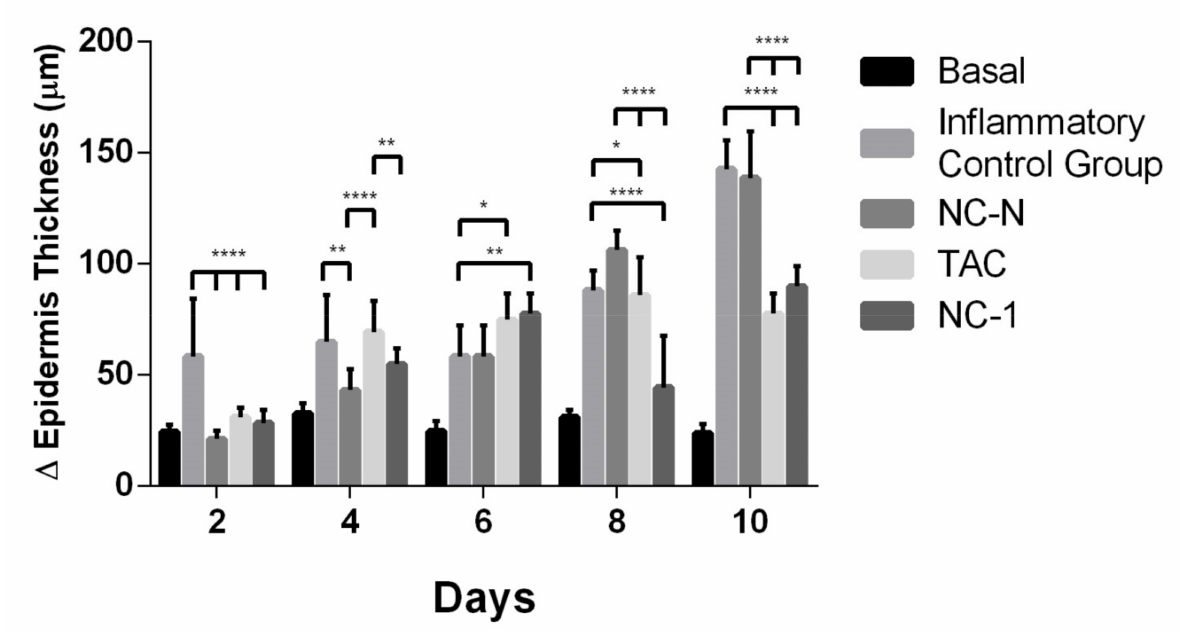
Figure 8. Effect of TAC, non-loaded, and TAC-loaded nanocapsules (NC-N and NC-1) on the variation of epidermis thickness of male Balb/c mice ears induced by TPA. Statistical analysis performed on each group on days 2, 4, 6, 8, and 10 of treatment. ANOVA statistical test with Tukey post-test, with significance of * p < 0.05; ** p < 0.01; and **** p <